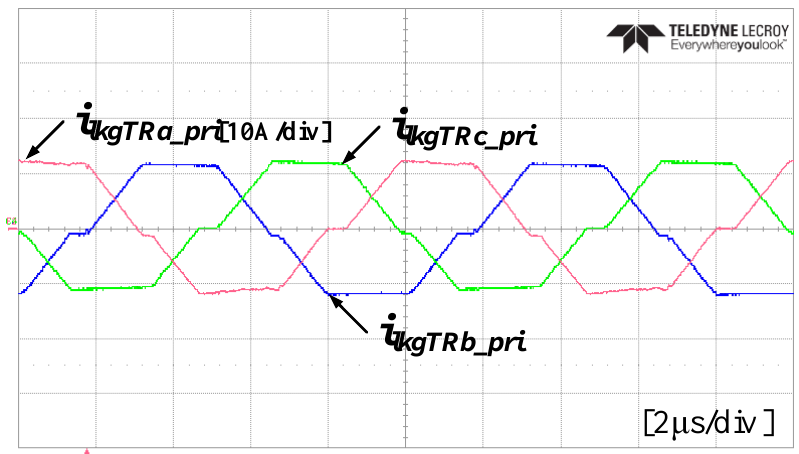
Figure 19. Experimental waveforms of 3-phase current in the primary side transformer.